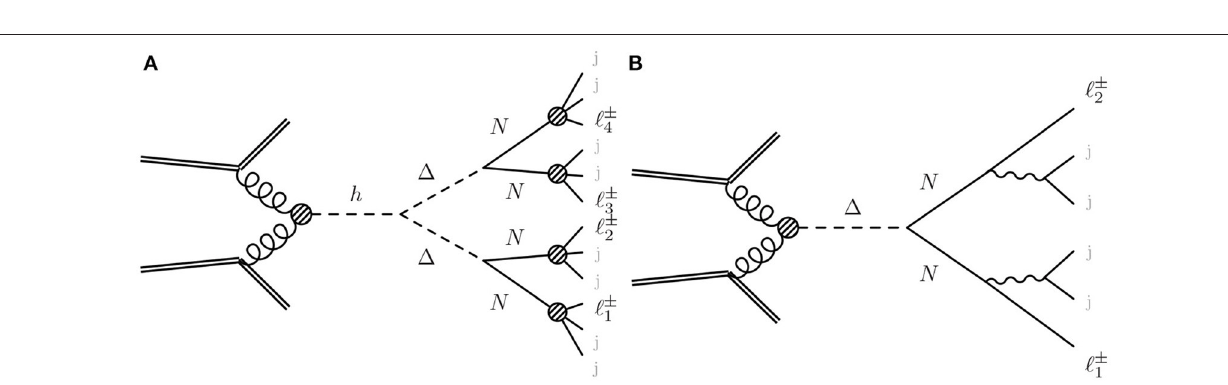
FIGURE 32 | Feynman diagrams depicting gluon fusion production of Majorana neutrinos via (A) SM Higgs boson ( h ) and (B) SU(2) R triplet Higgs ( H ) through their mixing in pp collisions [368, 448].